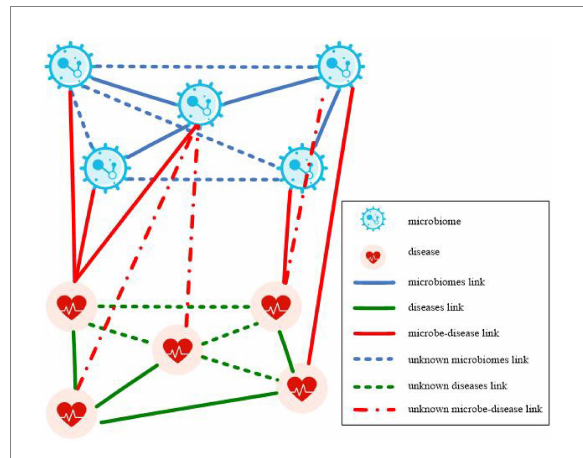
FIGURE 1 Microbe-disease heterogeneous network.